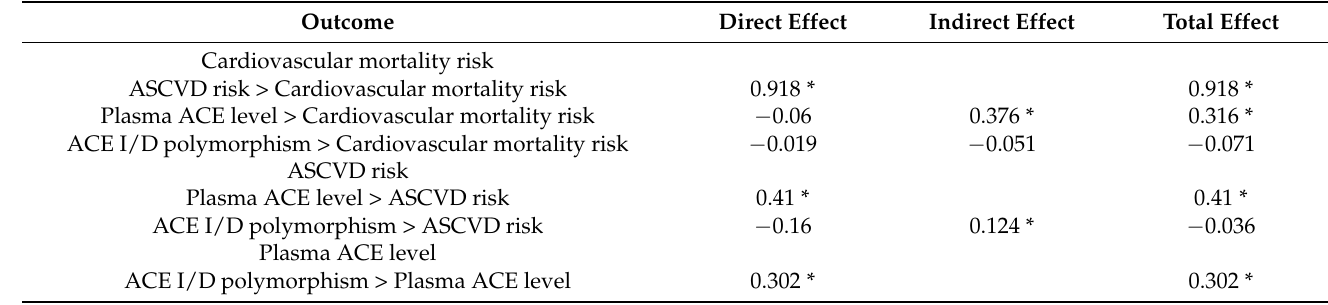
Figure 6. Relationship between ACE I/D polymorphism, plasma ACE level, atherosclerotic cardiovascular diseases risk, and cardiovascular mortality risk showed with path coefficient ( p -value) on each pathway. Table 6. Direct, indirect, and total effects of the path analysis.